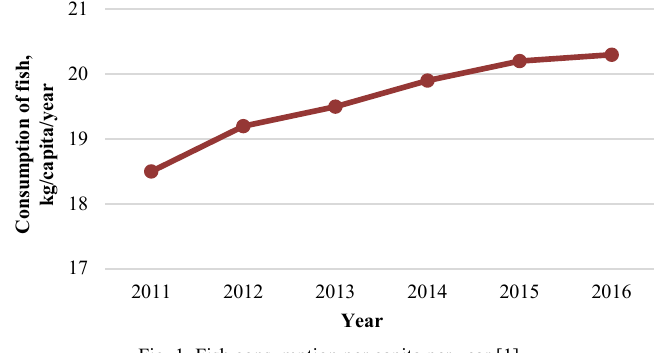
Fig. 1. Fish consumption per capita per year